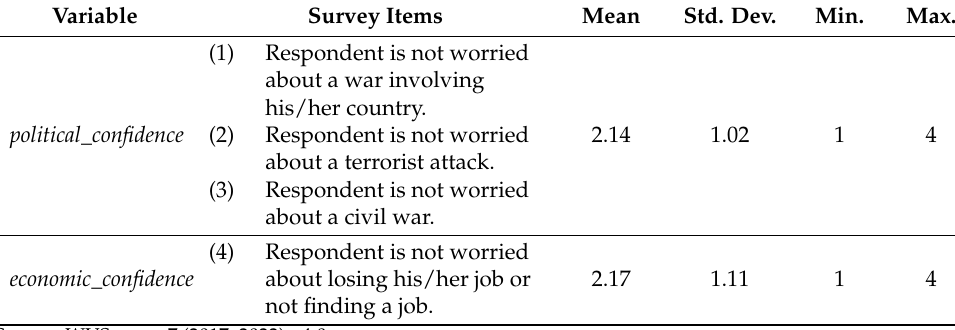
Table 3. Political and economic confidence in the future.